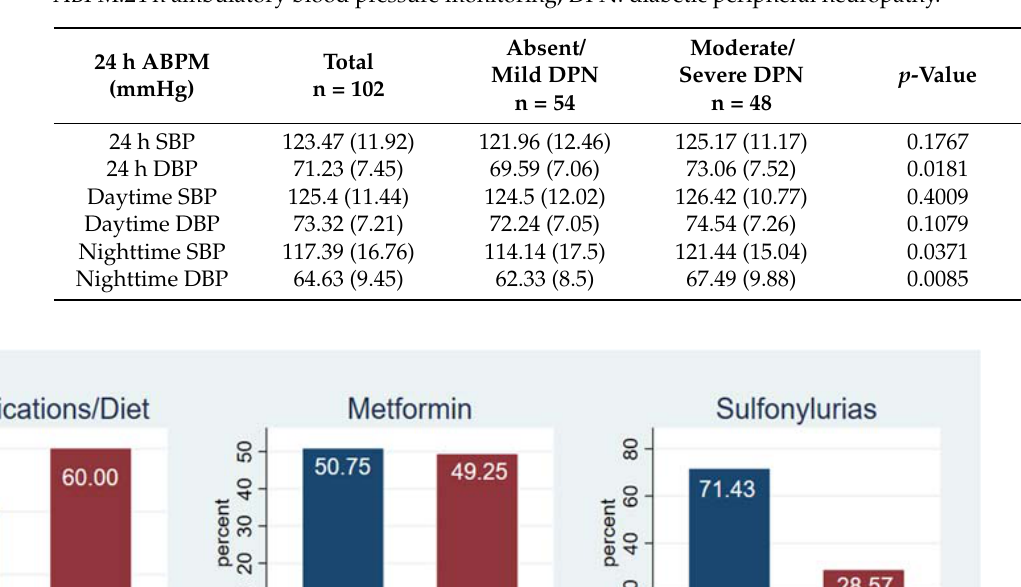
Table 2. Independent-sample t -tests for variables of the 24h ABPM analysis. Results are presented